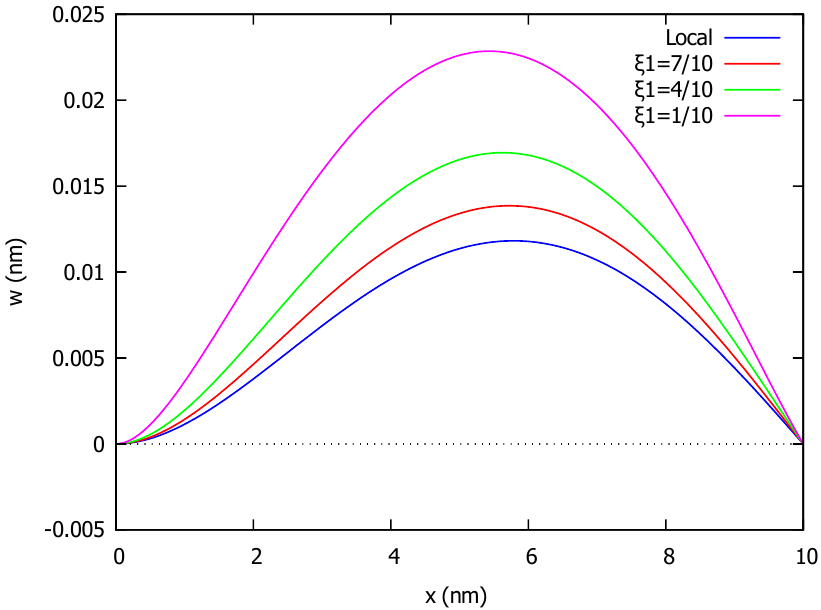
Figure 5. Deflection of clamped pinned beam (CP) under uniform load and various values of ξ 1 . From the results presented, it can be concluded that in all three cases of boundary conditions and loading cases, the solutions obtained are characterized by the softening effect that the nonlocal theory has on the beam deformation. It is observed that as the nonlocal material parameter τ increases, the deformation of the beam becomes greater in all cases. In addition, as the control parameter ξ 1 approaches the unit, the influence of the nonlocal model on the beam deformation decreases, and the nonlocal solution convergences to a classical (local)